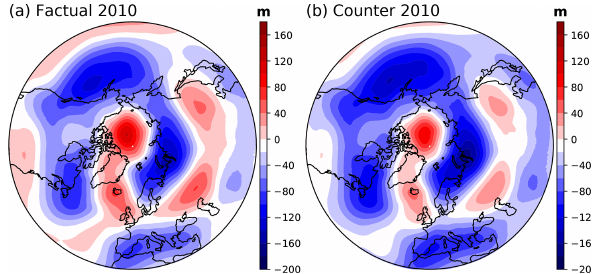
Figure 2. Geopotential height ( z 500 ) June–July–August (JJA) anomalies [m] for the Northern Hemisphere showing the averaged spectrally nudged dynamic situation over (a) factual members and (b) counterfactual members of the summer 2010 blocking. Anoma- lies were calculated relative to the ECHAM_SN 1980–2014 JJA